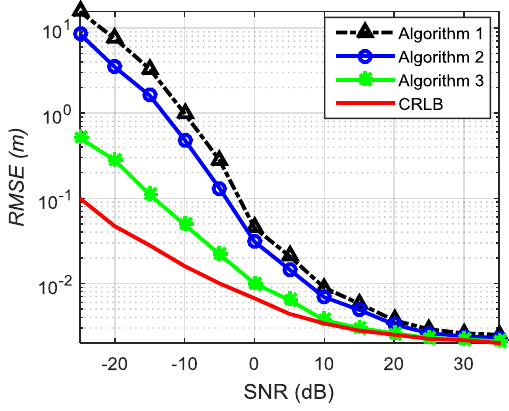
Figure 5. RMSE change with SNR for different algorithms